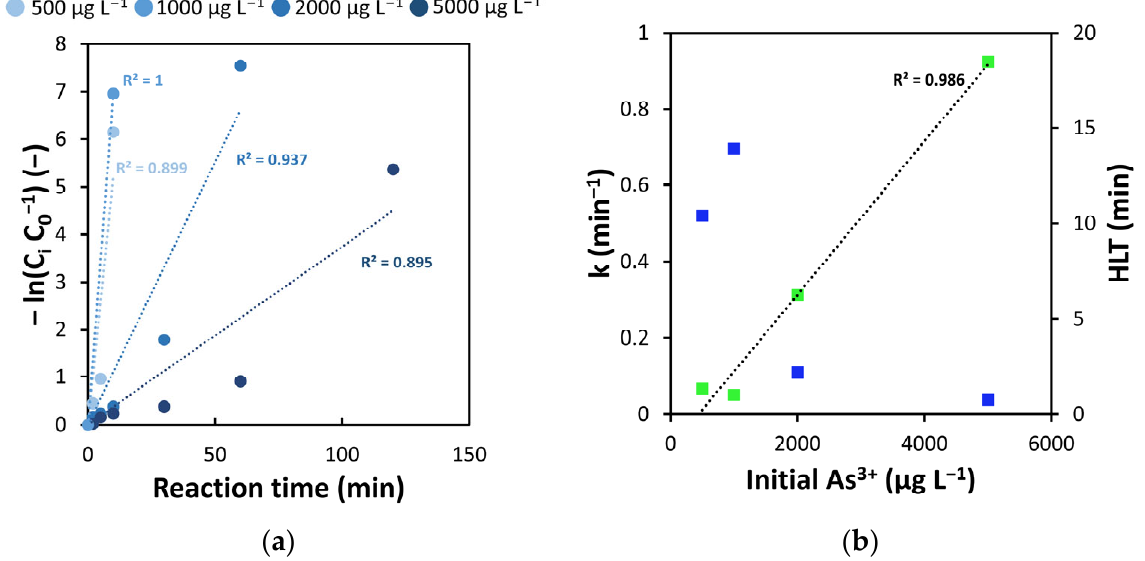
Figure 2. ( a ) Effect of initial As 3+ concentration on the electrochemical oxidation of arsenic. pH= 8; conductivity= 780 μ S cm − 1 . ( b ) Pseudo first ‐ order kinetic constants k ( blue ) and HLT ( green ) as a function of initial As 3+ concentration.